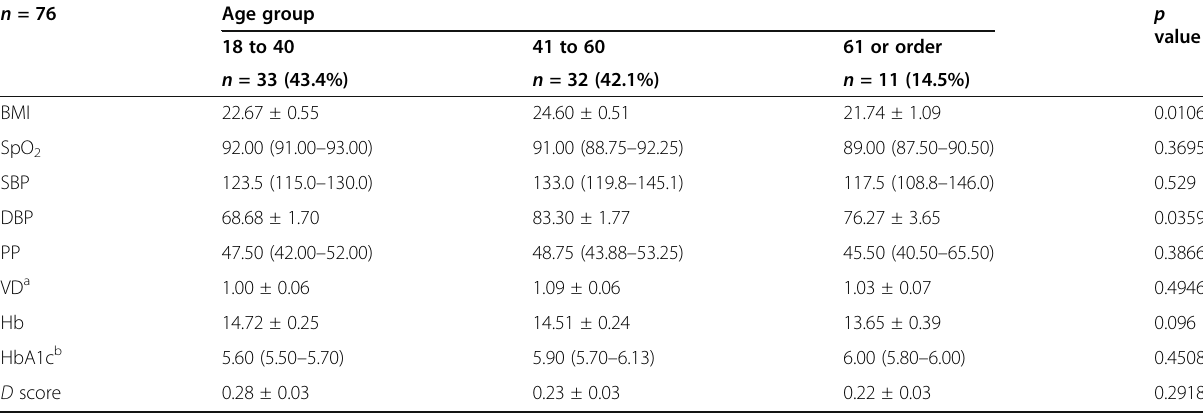
Table 2 Anthropometric variables, biochemical data, and poverty index by the age group in males. Values are presented as the mean ± SE or median (1st quartile – 3rd quartile). Data were analyzed by ANOVA or the Kruskal-Wallis test to compare variables among the three age groups. The D score was considered poor at ≥ 33.3%